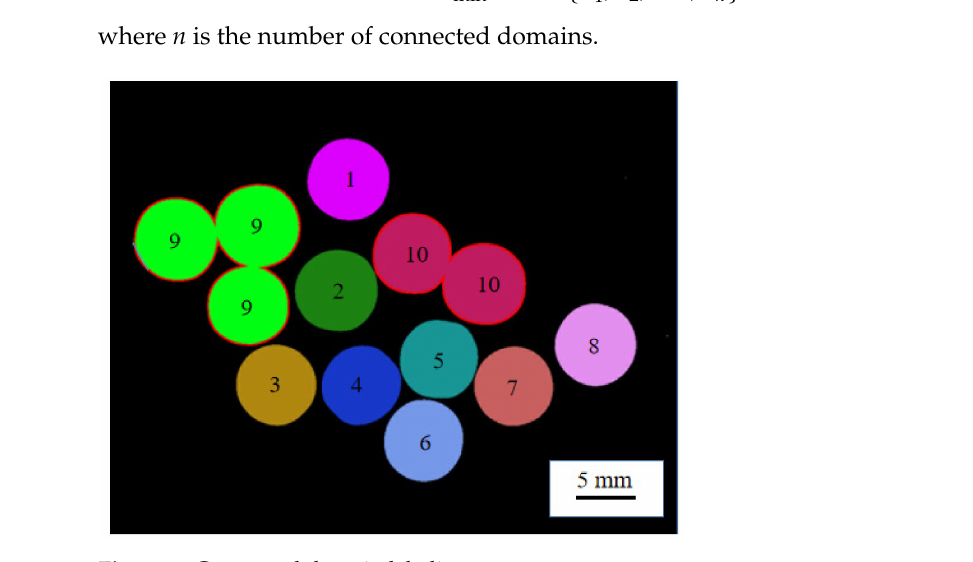
The connected domain labeling of the pearl images after binarization is shown in Figure 4. The pixel area of each connected domain was counted as S 1 , S 2 , · · · , S n , as shown in Table 1. The area sequence was sorted and the smallest area was S min , as expressed by Equation (1).